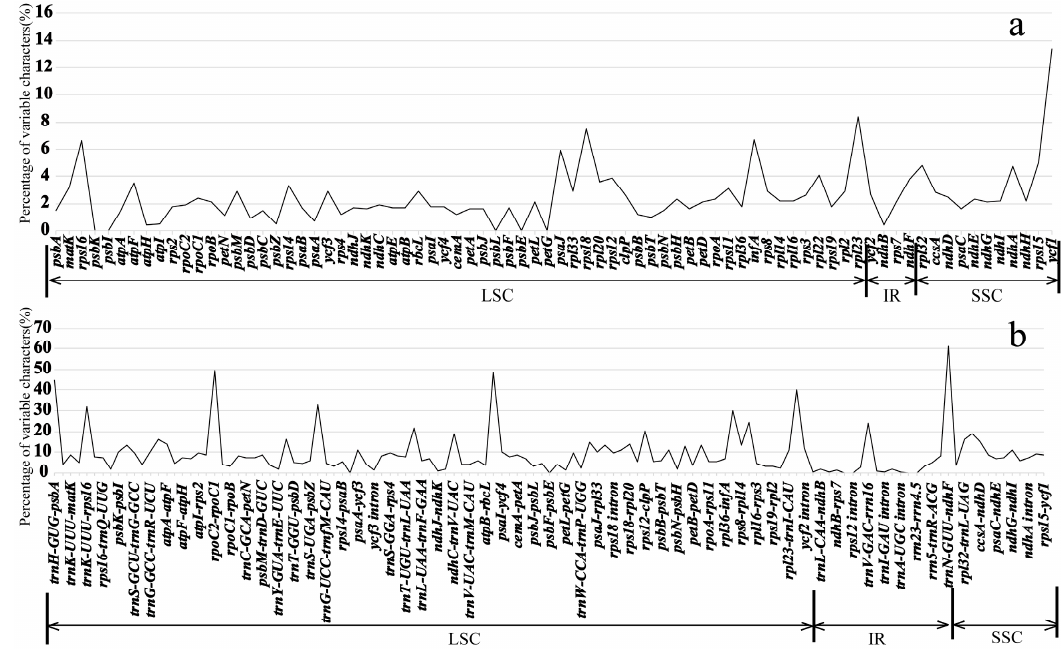
Figure 4. Percentages of variable characters in homologous regions among the chloroplast genomes of seven Lonicera species : ( a ) coding region and ( b ) noncoding region. The homologous regions are oriented according to their locations in the chloroplast genome.